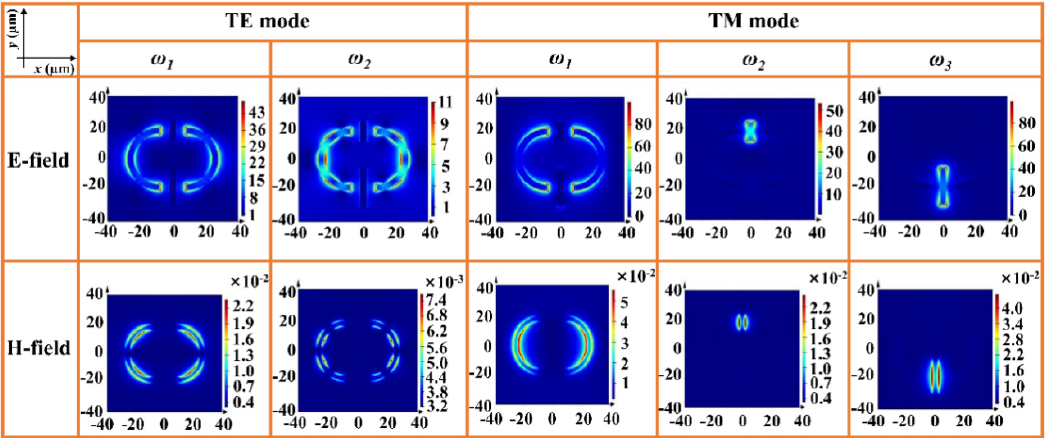
= 24 µ m in TE and TM 1